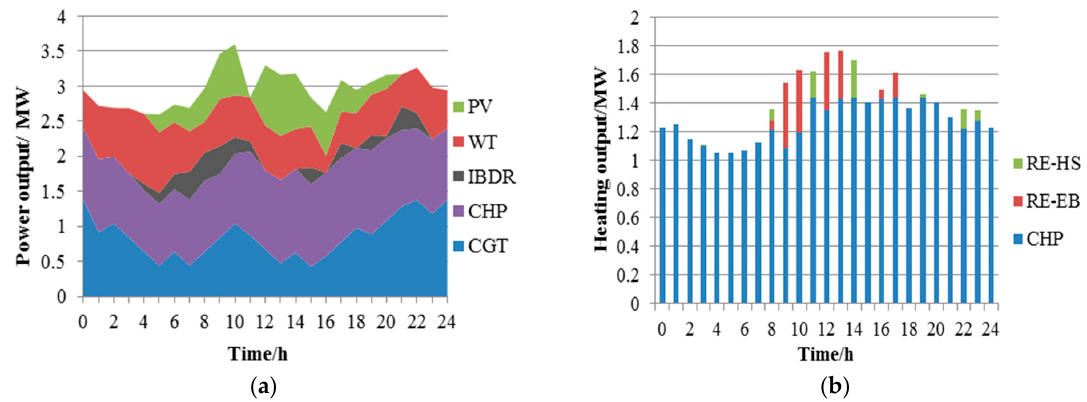
Figure 14. Scheduling results of HES operation after application of PBDR ( a ) and RE-HS ( b ) for Case 4 .